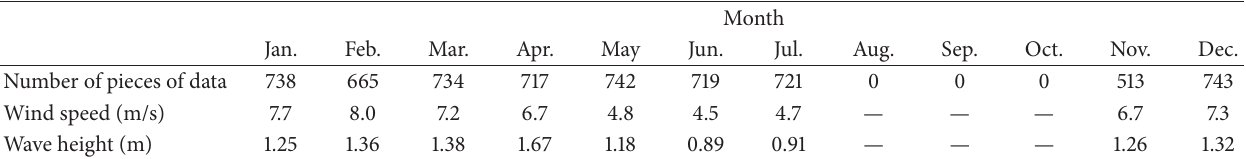
Table 2: Average wave height and wind speed per month in